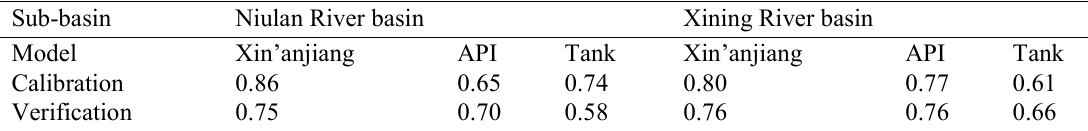
Table 1 Model performance in the Niulan and Xining River basins.